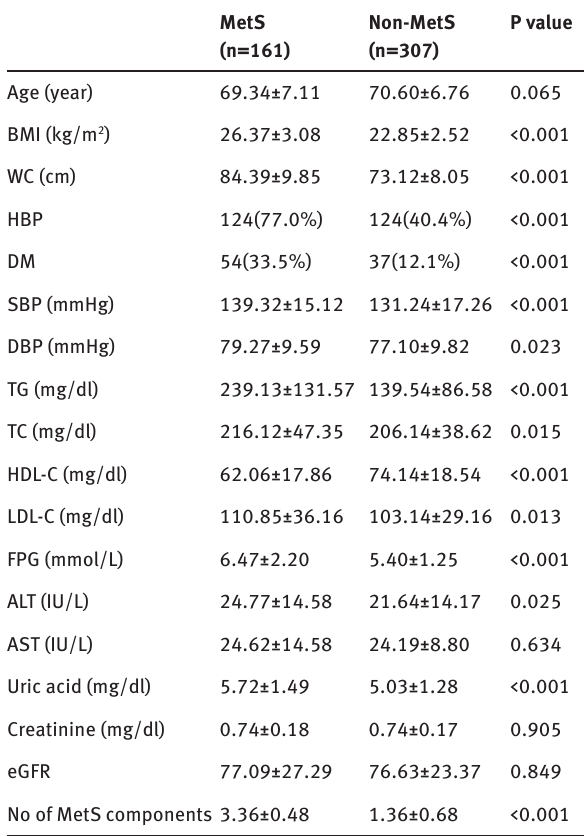
Table 1: Characteristics of the study